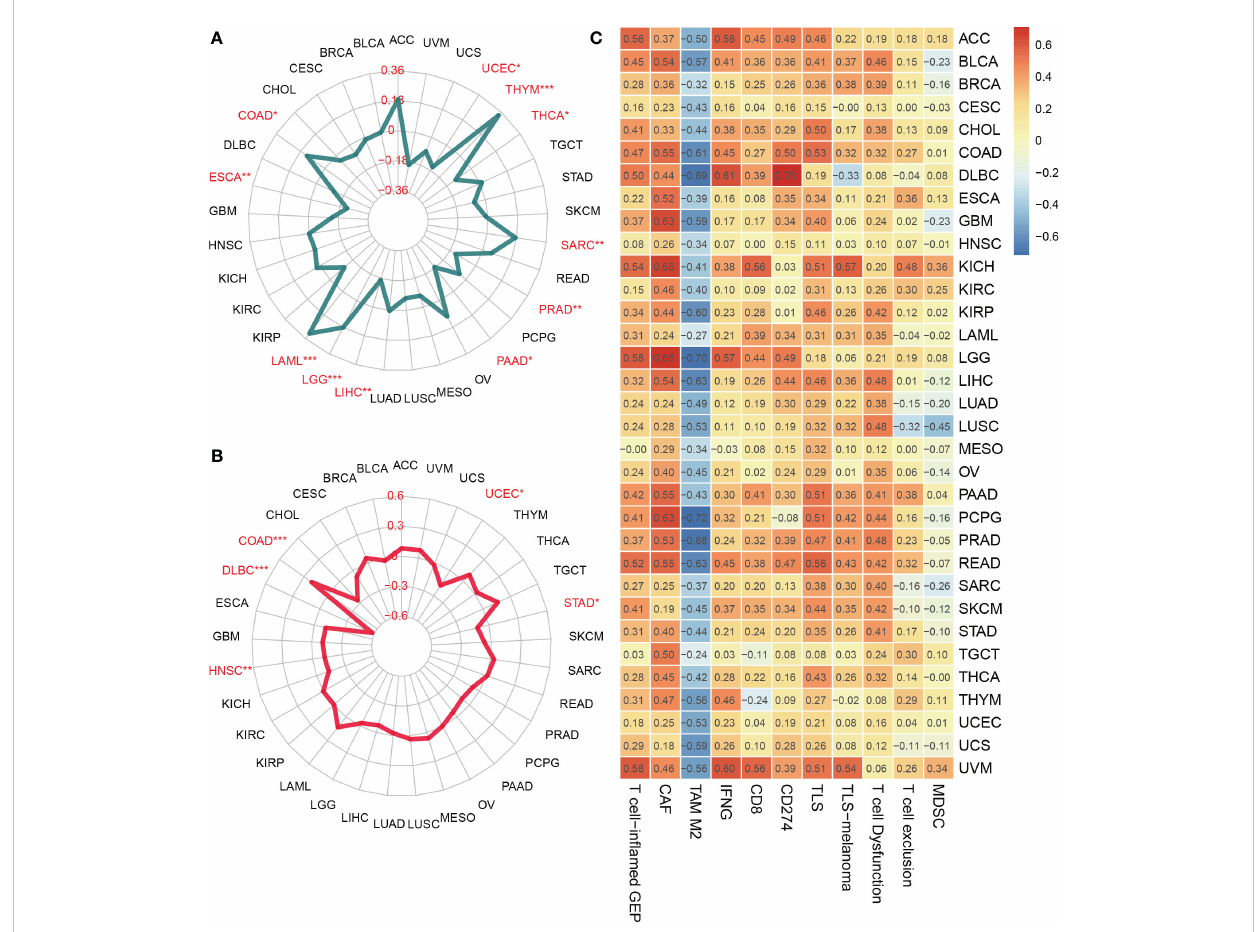
FIGURE 3 Relationship between SOCS3 expression and tumor mutational burden (TMB), microsatellite instability (MSI) and immune-gene signatures. (A) TMB. (B) MSI. (C) immune-gene signatures. The meaning of the symbol: *P < 0.05, **P < 0.01, ***P <